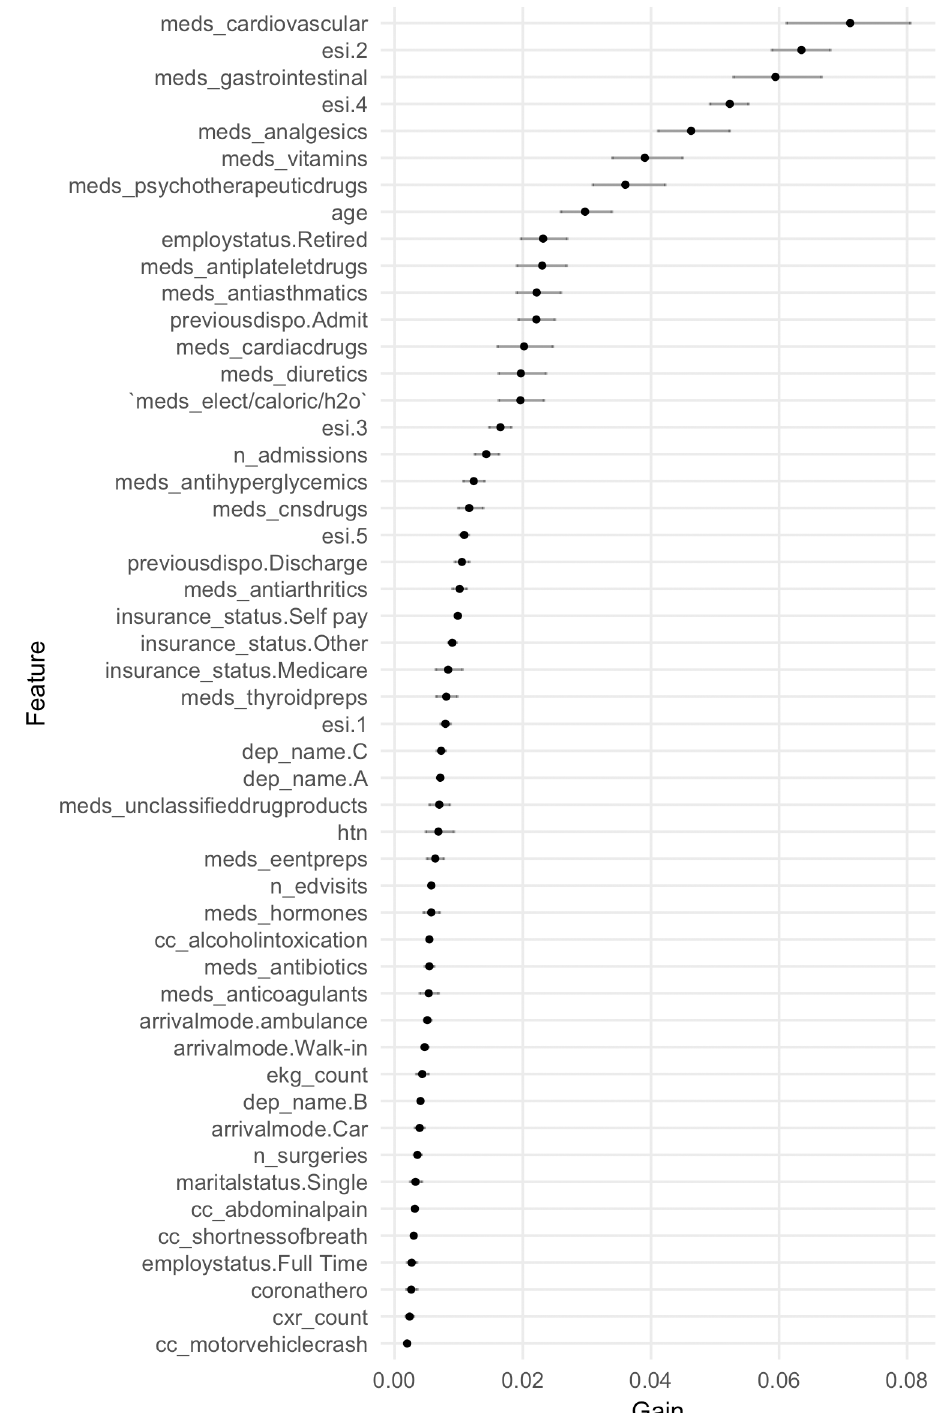
Fig 3. Variables from the full XGBoost model ordered by information gain. Row names represent the variables in the design matrix post one-hot encoding (see S1 Table for name descriptions). Points represent the mean information gain from a hundred runs of XGBoost. Horizontal lines show bootstrapped 95% confidence intervals.